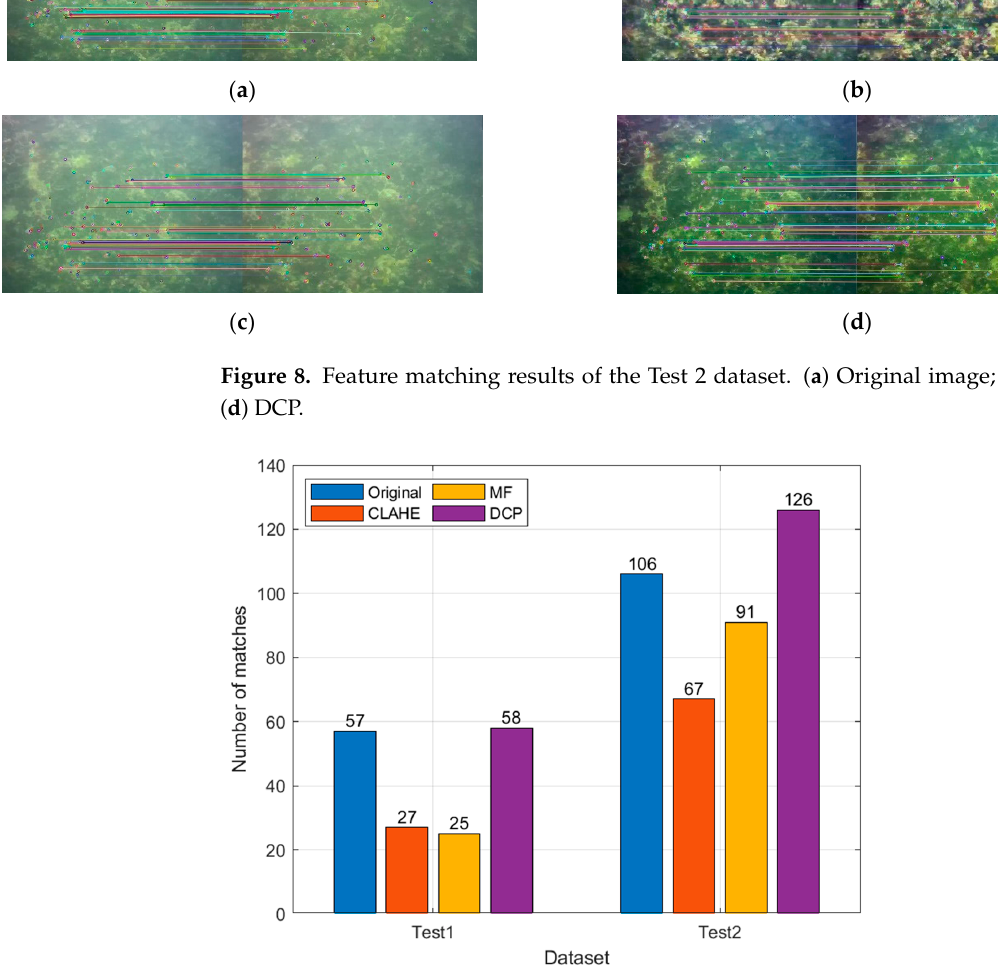
Figure 9. Number of feature matches.